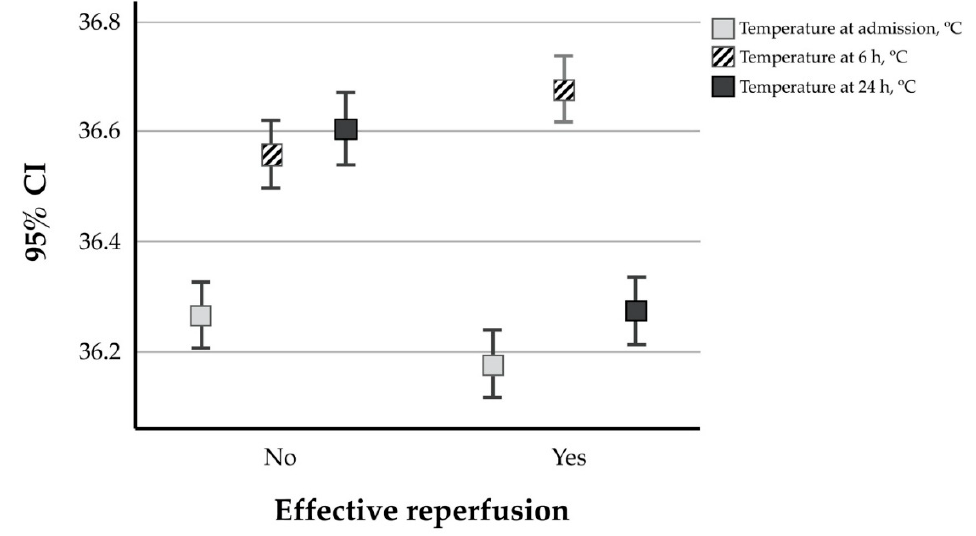
Figure 1. Temperatures at admission and 6 h 24 h in relation to reperfusion effectiveness.